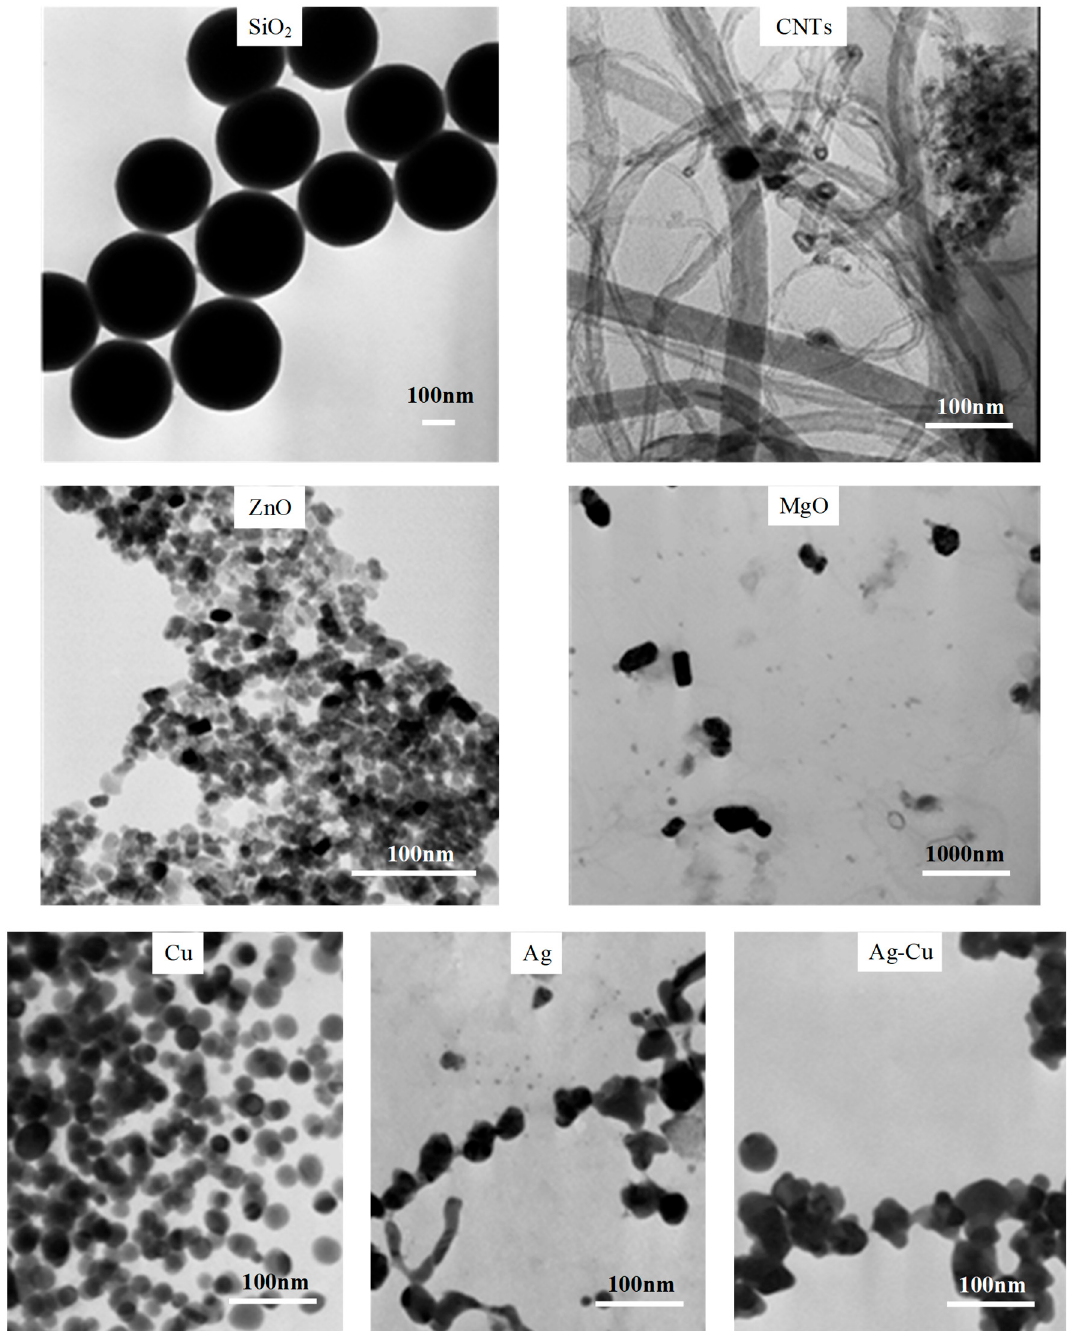
Figure 2. Transmission electron microscopy (TEM) images of prepared NPs.